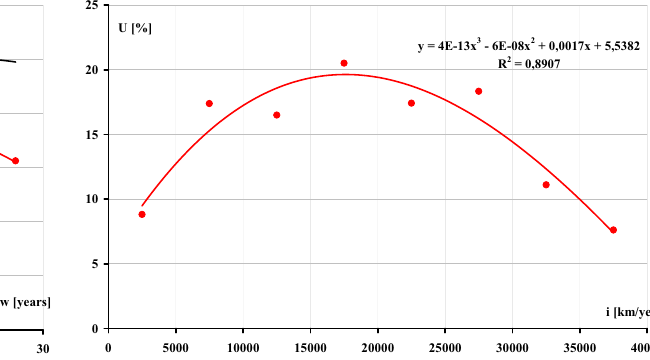
Figure 10: Dependence of the share of vehicles with faults among vehicles in a given range of intensity of